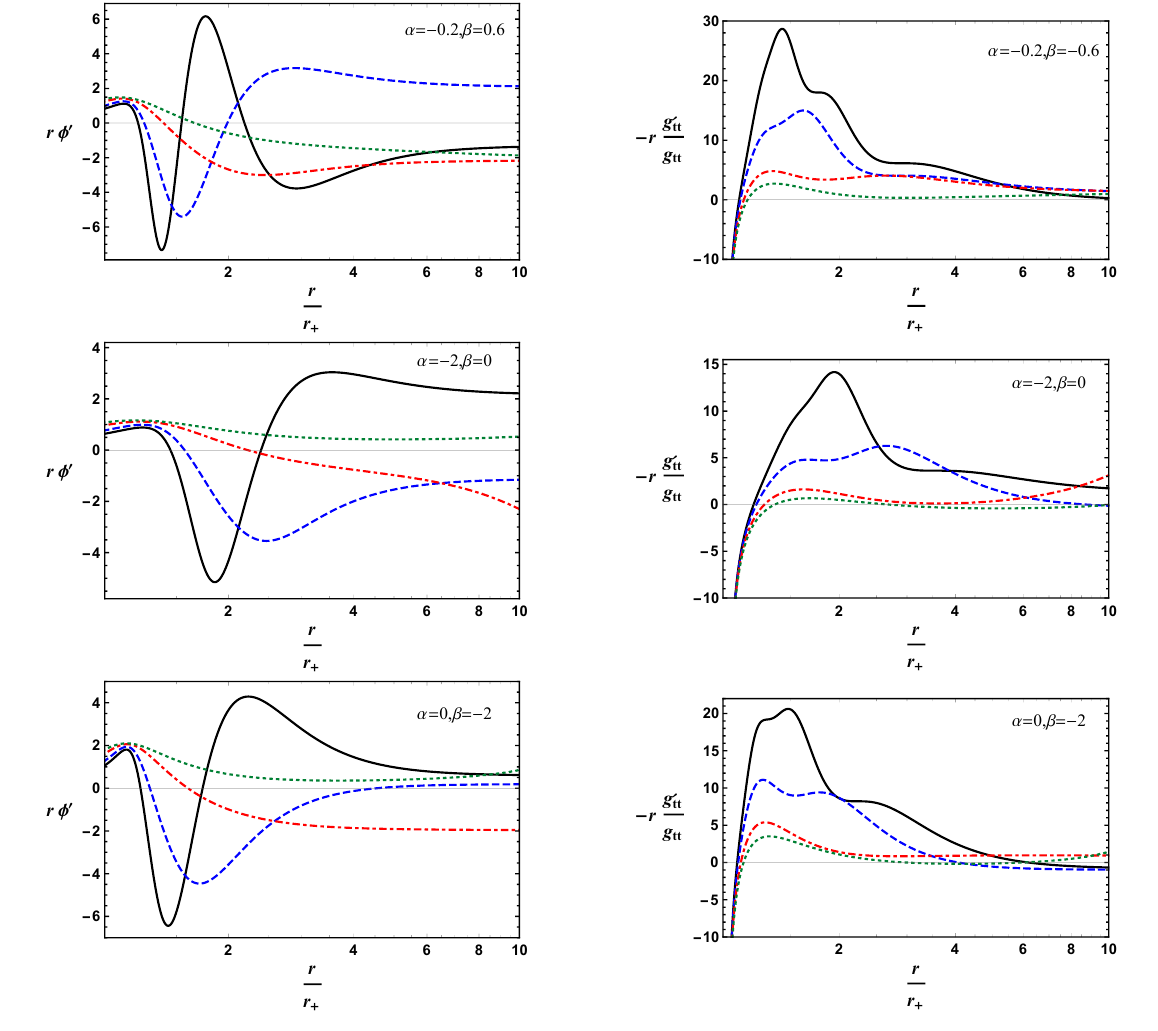
Figure 9 . The behavior of rφ 0 and − rg 0 /g tt versus r for the temperatures T/T c = 0 . 965 (solid), tt 0 . 945 (dashed), 0 . 895 (dot-dashed) and 0 . 845 (dotted). One can see fewer Josephson oscillations and the jump in the derivative of the metric element as the temperature is lowered. Here we take κ/µ = 1